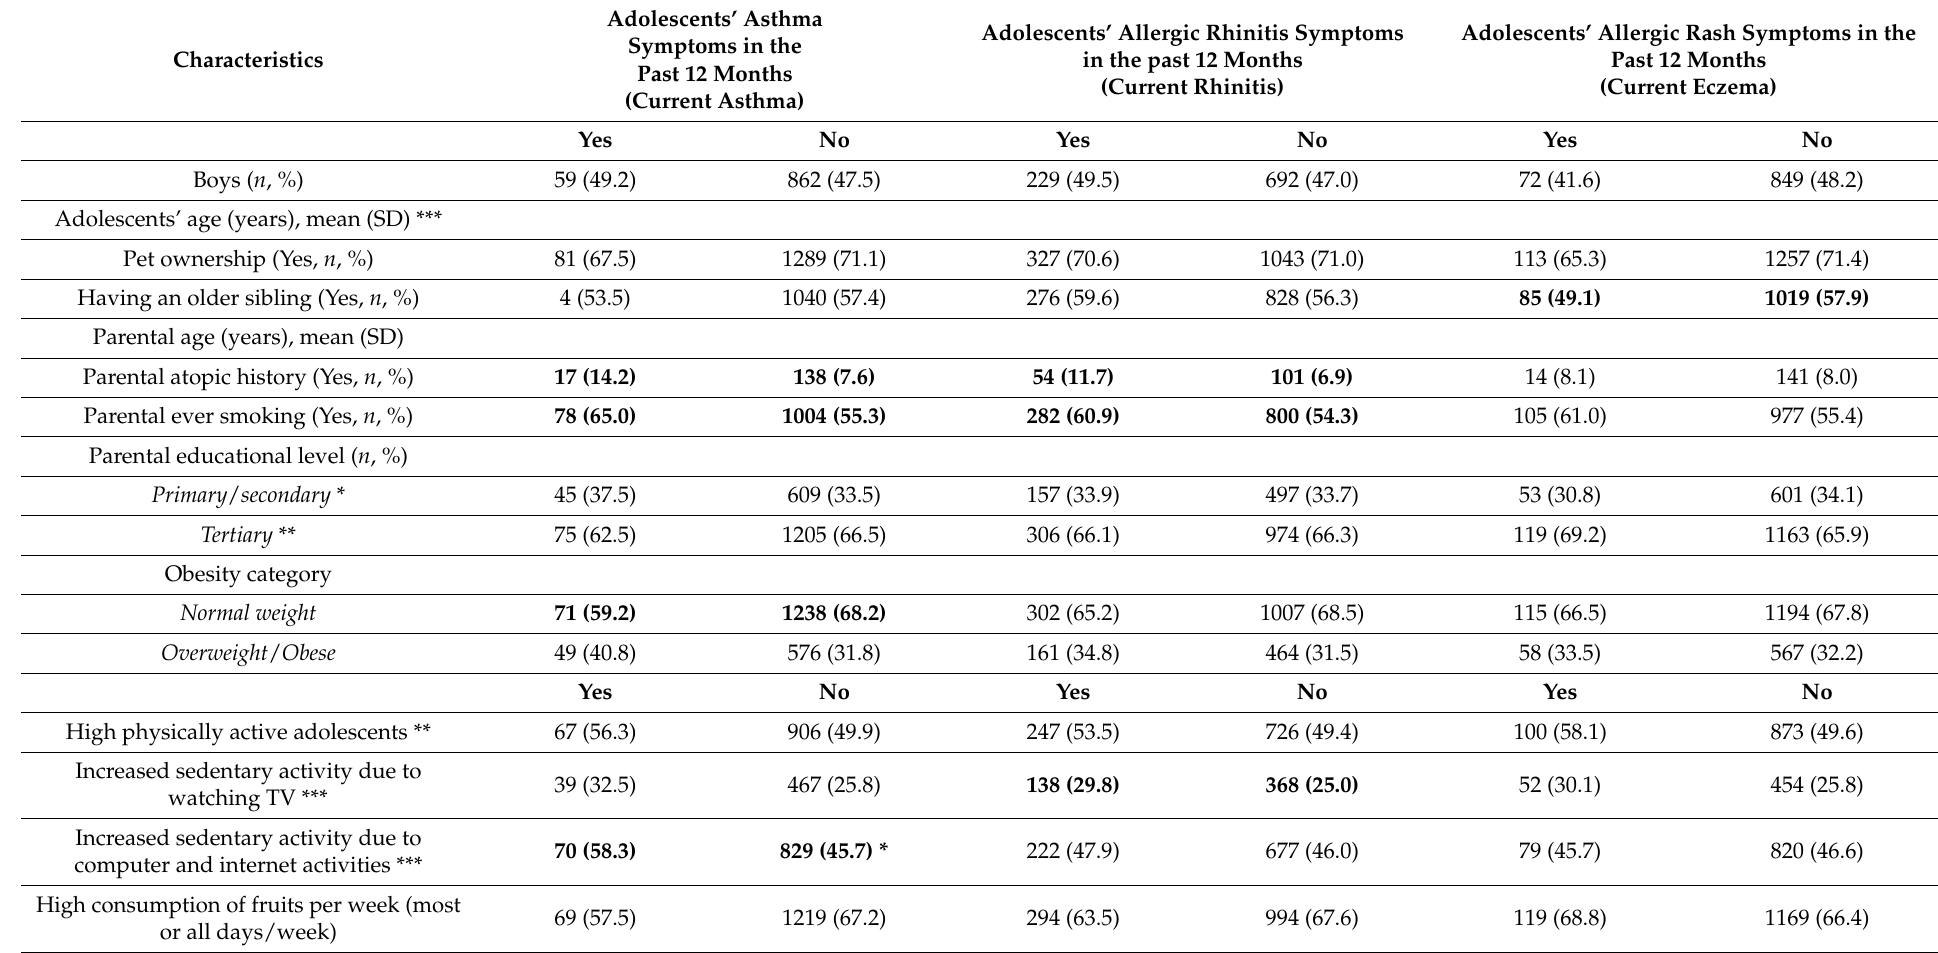
Table 1. Characteristics of the total sample according to adolescents’ atopic diseases’ history status ( n =